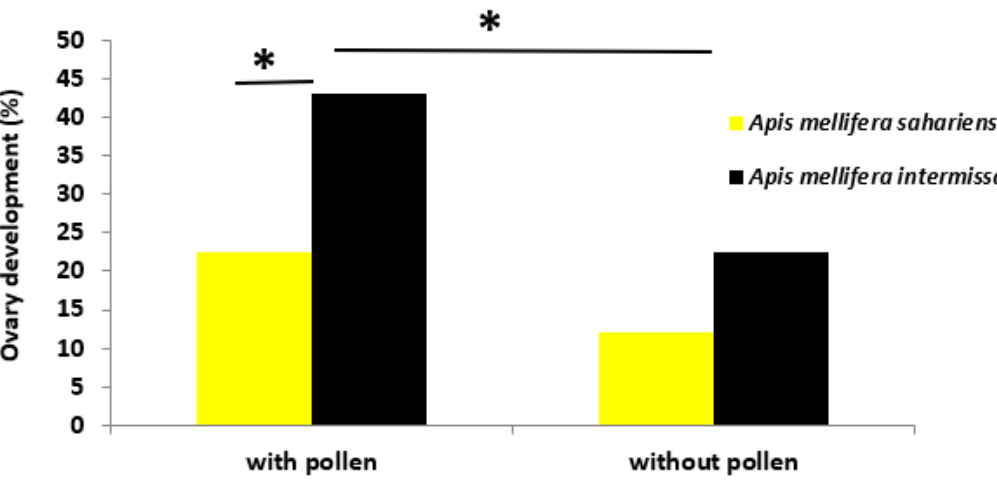
Figure 3. Ovary development rate in both subspecies of bee ( Apis mellifera intermissa and Apis mellifera sahariensis) , pollen-fed (control) and pollen-deprived. The asterisk (*) indicates the significance of the chi-squared ( χ 2 ) test at a significance level of p -value < 0.05.